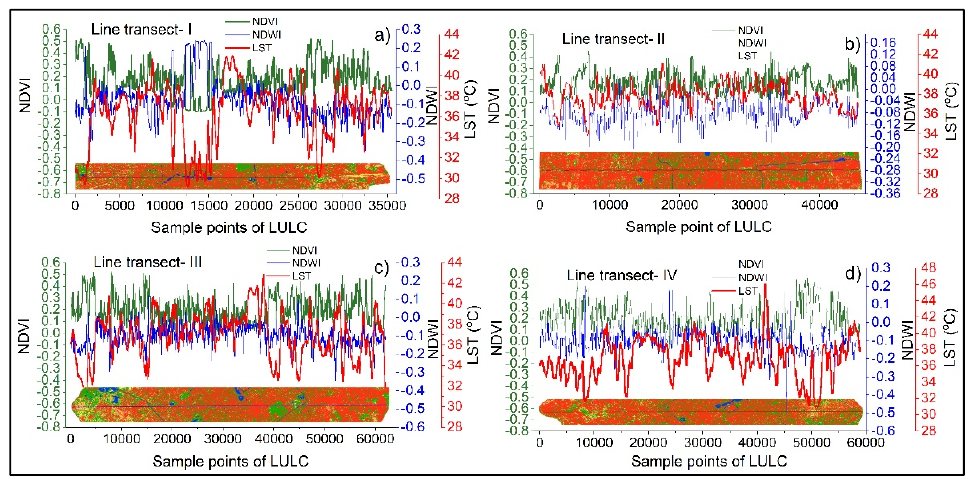
Figure 3. Relationship among LULC, LST, NDVI, and NDWI profile of ( a ) line transect I, ( b ).transect II, ( c ) line transect III, ( d ) and line transect IV.